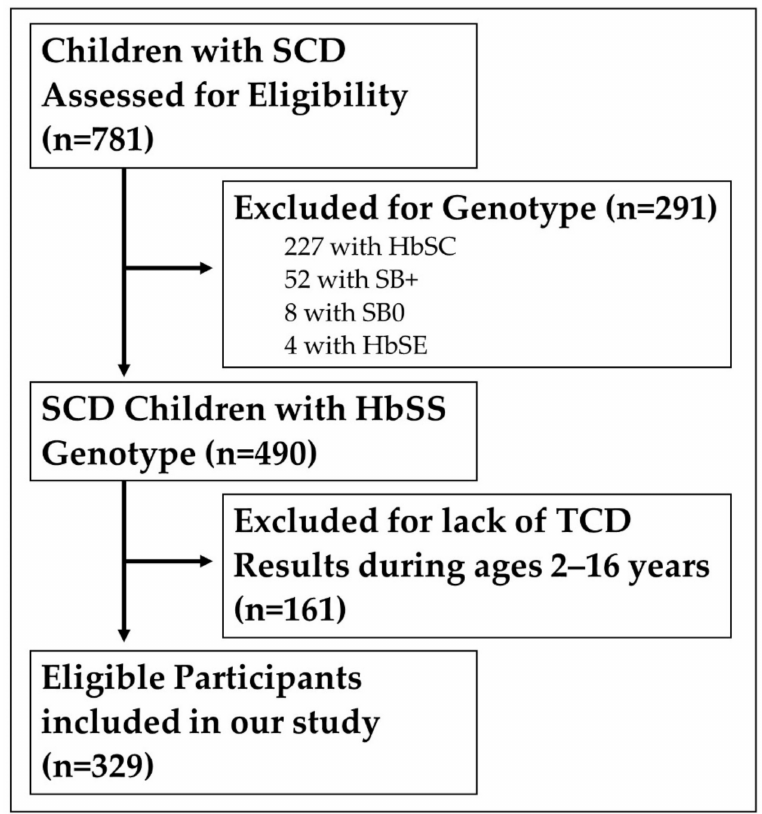
Figure 1. Patient inclusion flow chart. Outline of reasons for patient inclusion or exclusion in our study. SCD genotypes other than HbSS were excluded because they carry varying stroke risks and there were too few with TCD results to perform an analysis with the genotype as a covariate. Patients were required to have results from a minimum of one TCD for